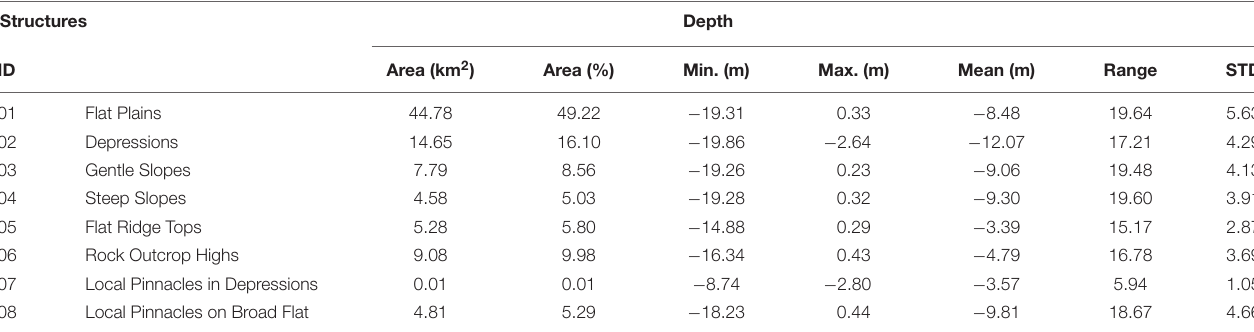
Figure 3E . In relation to the sedimentological composition (gravel, sand, and mud), it is observed that in the Depressions (ID 02) there is a predominance of sand, while in the Gentle Slopes (ID 03) there is an alternation between the dominance of the percentages of gravel and